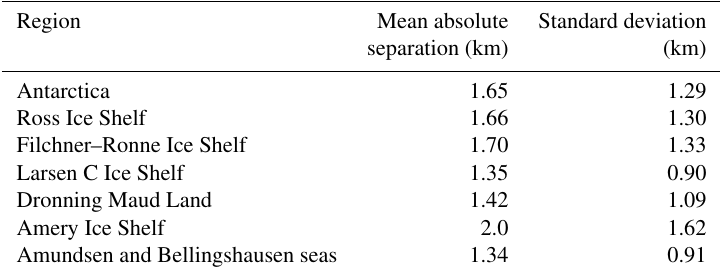
Figure 12. Spatial distributions of ICESat-2-derived break in slope (Point I b ) in each individual region (black boxes in Figs. 10 and 11). For comparison, ICESat-derived Point I b locations are shown as the yellow dots (Brunt et al., 2010a), ASAID-derived Point I b is shown as the green line (Bindschadler et al., 2011), DInSAR-derived Point F in 2018 is shown as the pink line (Mohajerani et al., 2021), and DInSAR- derived Point F in 2017 on Thwaites Glacier (panel h ) is shown as the blue line (Milillo et al., 2019). In all subplots, data are superimposed over recent ice surface velocity magnitudes (Rignot et al., 2017) in Antarctica polar stereographic projection (EPSG:3031). Table 5. The mean absolute separation and standard deviations between ICESat-2-derived Point H and ASAID-derived Point H (Bindschadler et al.,